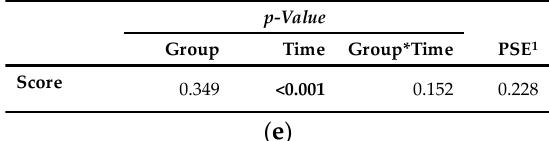
Figure 5. ( a ) Percentages of different categories (posture and behaviour, digestive system, respiratory system, circulatory system and rectal temperature) of cumulative score from maximum reachable score (29 points/100%) of cows fed a non-supplemented (CON) or an L-carnitine-supplemented diet (25 g/d from 6 weeks ap up to week 15 pp , CAR). ( b ) Data statistics. 1 pooled standard error.